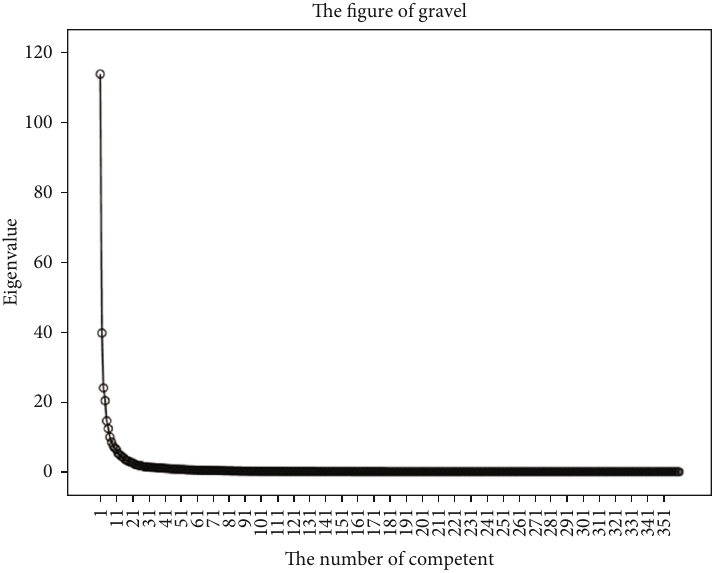
Figure 1: The fi gure of